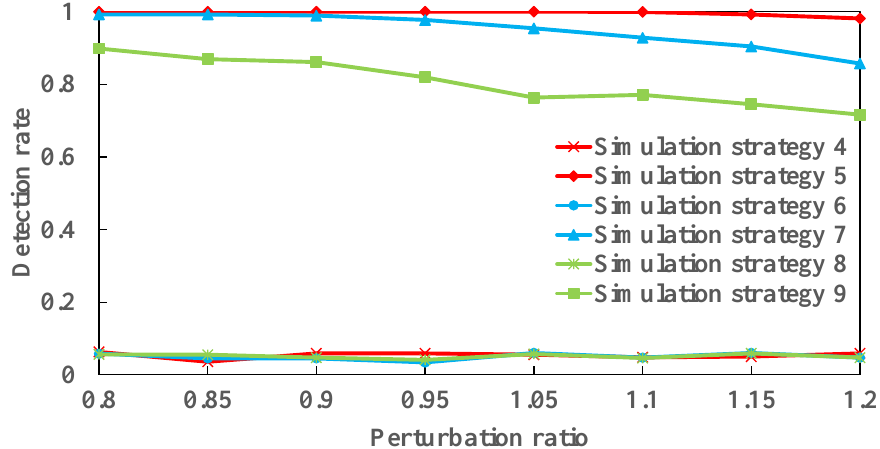
Figure 8. The detection rates in simulation strategies 4, 5, 6, 7, 8, and 9 when the perturbation ratio increases from 0.8 to 1.2.